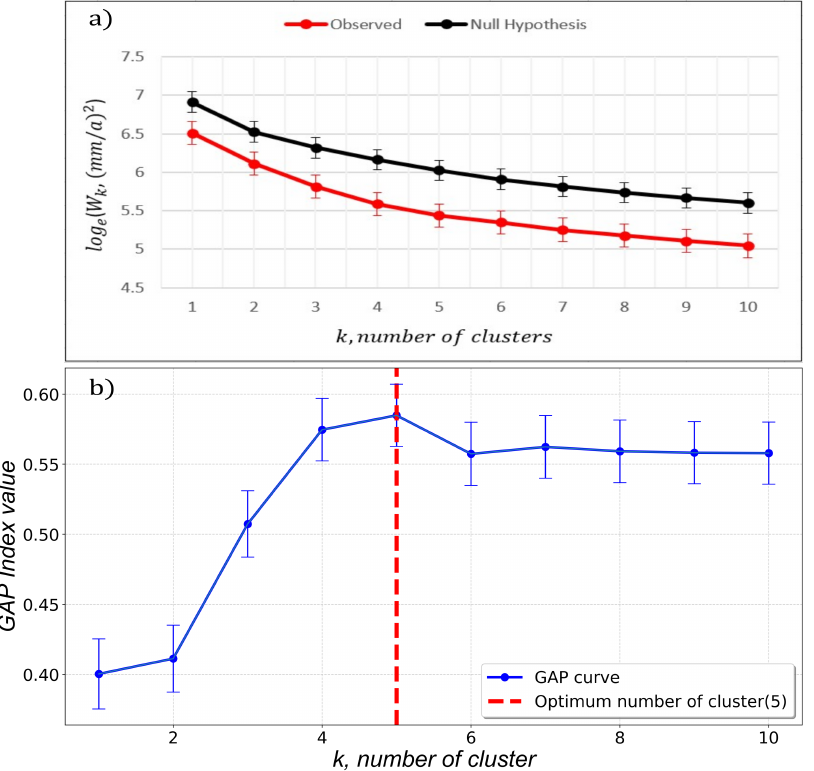
Figure 4. The gap statistic algorithm: ( a ) Plot of log e ( W k ) as a function of k , the number of clusters; ( b ) the difference between the two curves in ( a